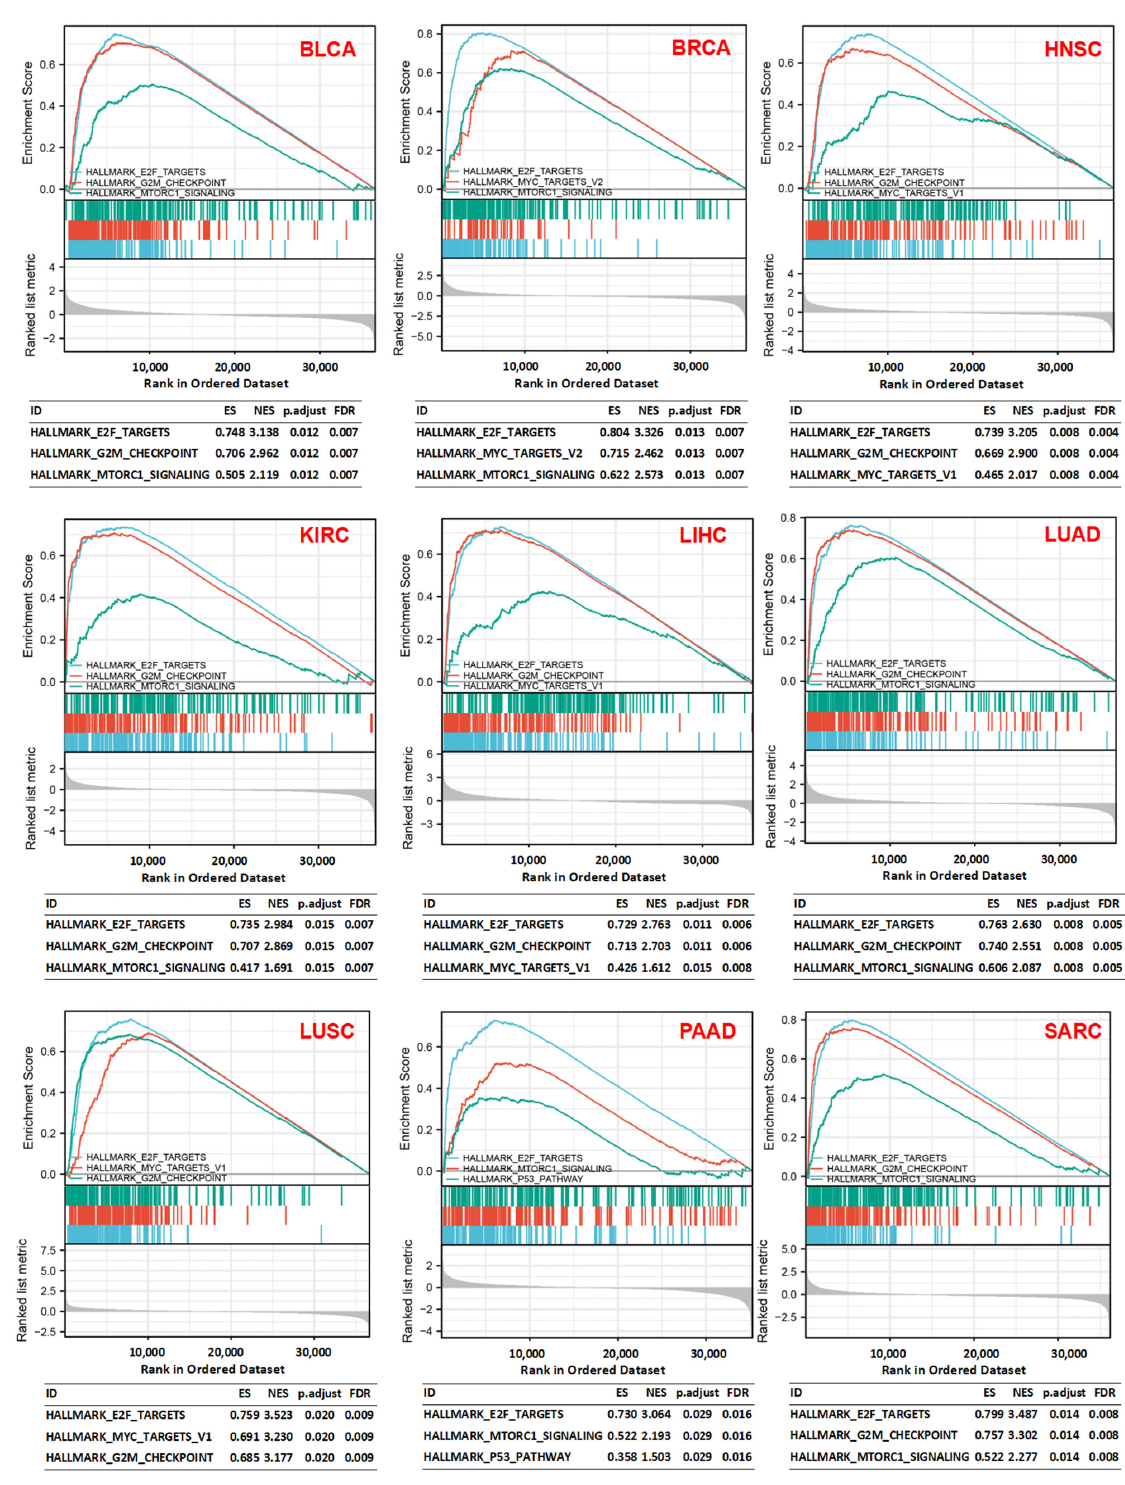
Figure 6. Hallmark gene set enrichment analysis (GSEA). “HALLMARK E2F TARGETS”, “HALL- MARK G2M CHECKPOINT”, “HALLMARK MTORC1 SIGNALING”, “HALLMARK MYC TAR- GETS”, and the “HALLMARK P53 PATHWAY” enriched in the high CDK1 expression group com- pared to the low CDK1 expression group in various tumors. Each line represents one particular gene set with a unique color, with upregulated genes located on the left and the ones with the highest expression on the far left, while downregulated genes are shown on the right. NES: normalized enrichment score; FDR: false discovery